Question: Give a one-sentence summary of this figure.
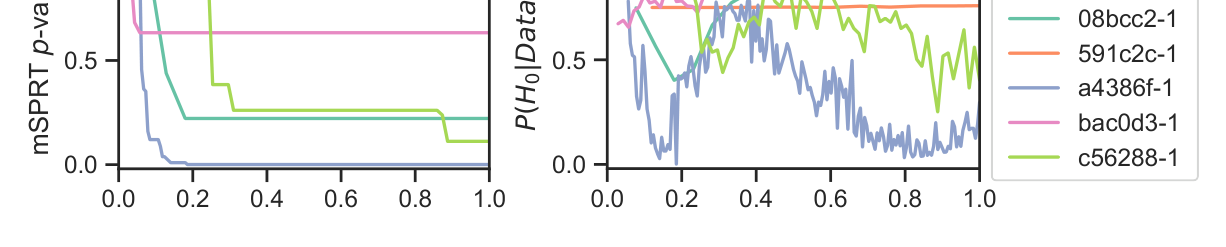
Answer: 2: Change in (left) p-values in a mixed sequential probability ratio test (τ 2 = 5.92e-06) and (right) posterior belief in the null hypothesis (P(H0|data)) in a Bayesian hy- pothesis test (V 2 = 5.93e-06, P(H0) = 0.75) during the experiment for five experiments selected at random. The experiment duration (x-axis) is normalised by its overall runtime. Only results for Metric 4 are shown.